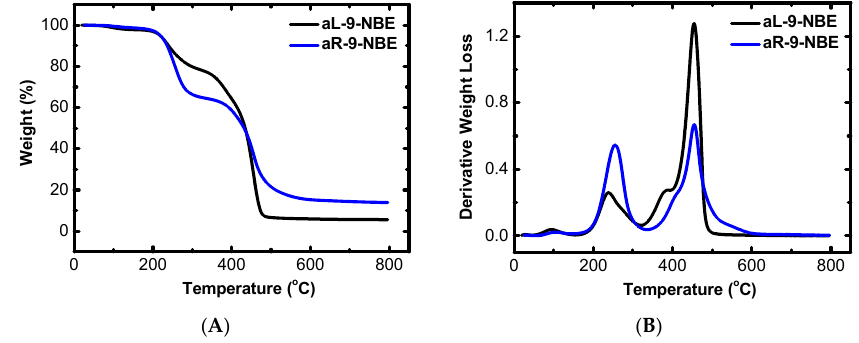
Figure 7. Weight loss with temperature ( A ) and derivative weight loss with temperature ( B ) for aL-9-NBE and aR-9-NBE monomers, as indicated. Table 1. Thermal decomposition of aL-9-NBE and aR-9-NBE monomers.